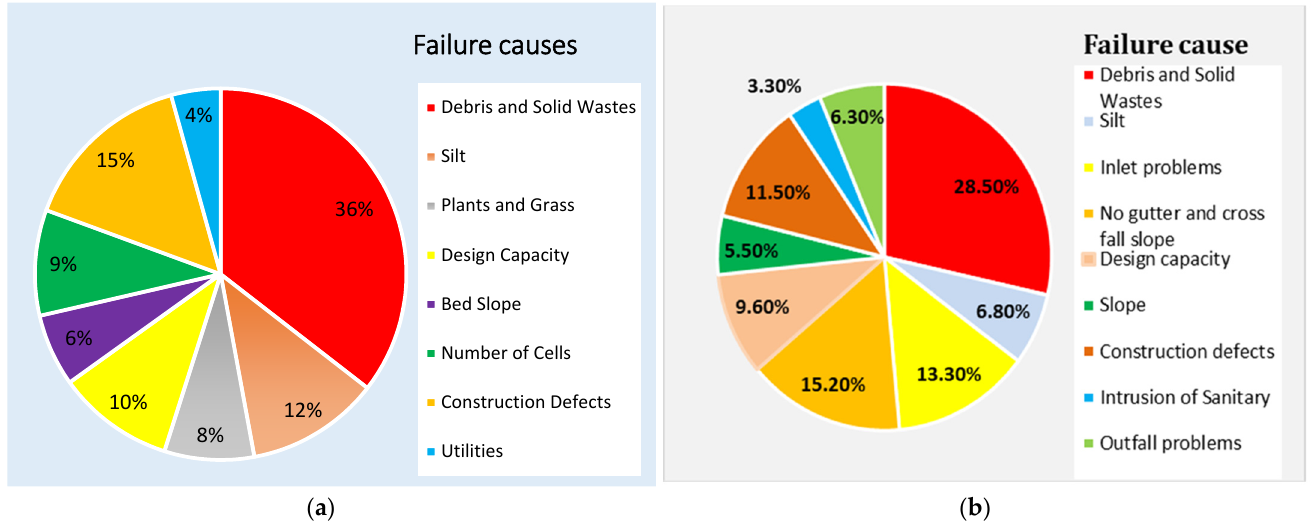
Figure 6. Priority of failure causes for cross-drainage ( a ) and longitudinal drainage ( b ) systems.